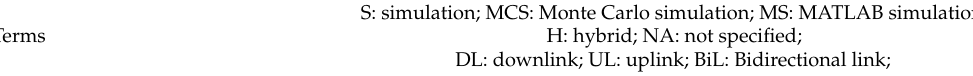
 HO rate vs. the occurrence rate, and throughput vs. the weight